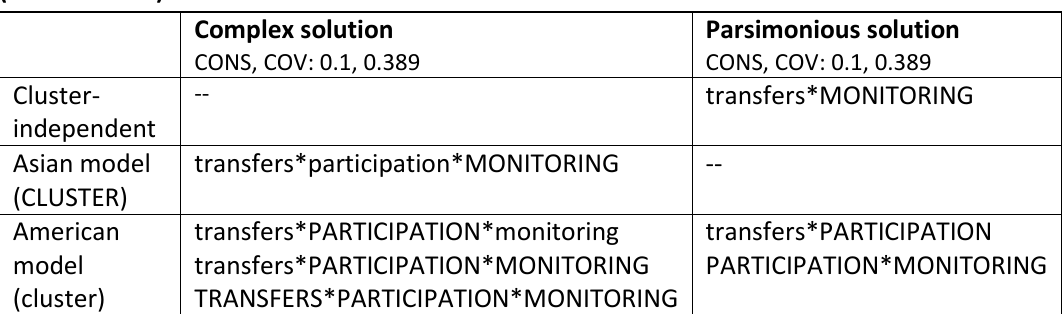
Table A2.8 Complex and parsimonious solutions to unsuccessful drought